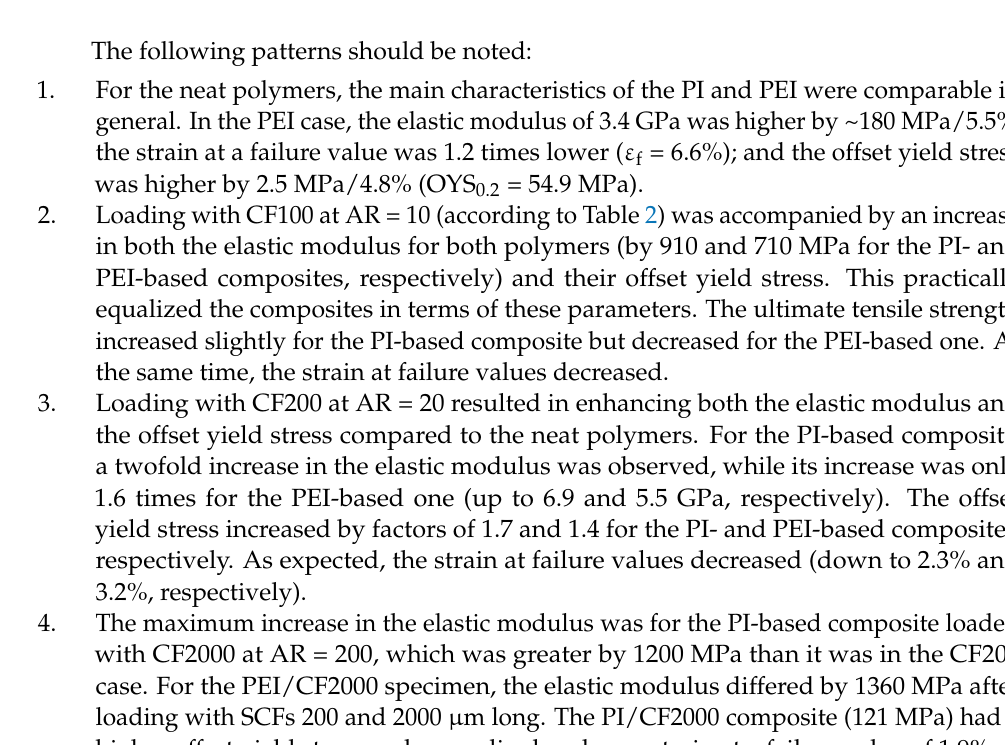
Table 3. The mechanical properties of the PI and PEI-based composites loaded with SCFs of various lengths. Ultimate Tensile Strength, UTS (MPa)